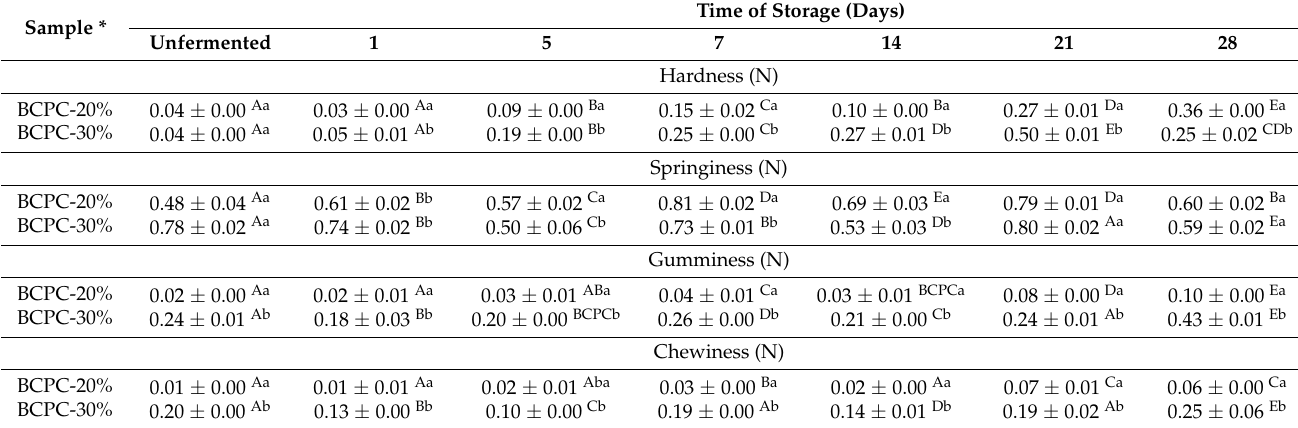
Table 5. Changes of the textural parameters during